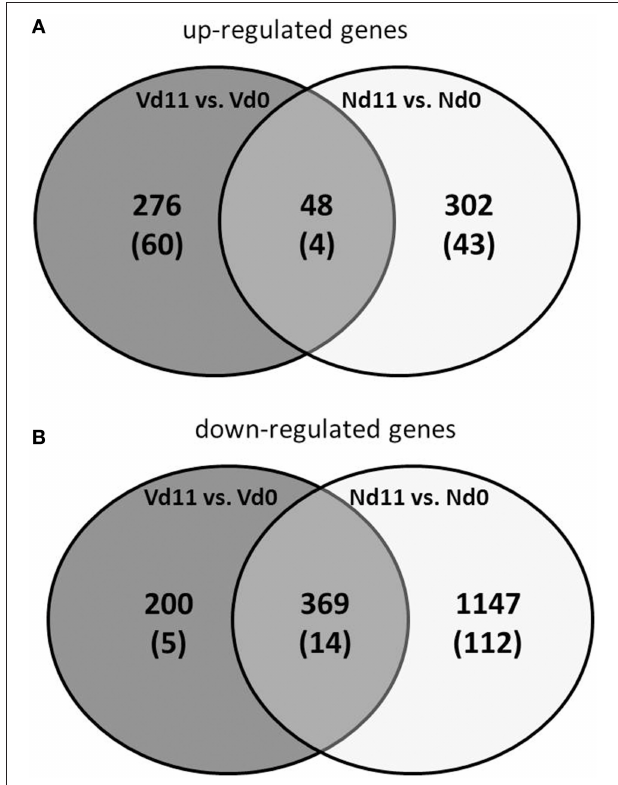
FIGURE 2 | Venn-diagram of the number of up-regulated (A) and down-regulated (B) genes expressed more than 3-fold ( p < 0.01) in the liver of vaccinated mice infected with P. chabaudi toward the end of the crisis phase on day 11 p.i. (Vd11) in comparison to constitutive expressions day 0 p.i. (Vd0). Nd11 vs. Nd0 indicates number of those genes identified in the liver of non-vaccinated mice. Numbers in brackets indicate genes more than 10-fold